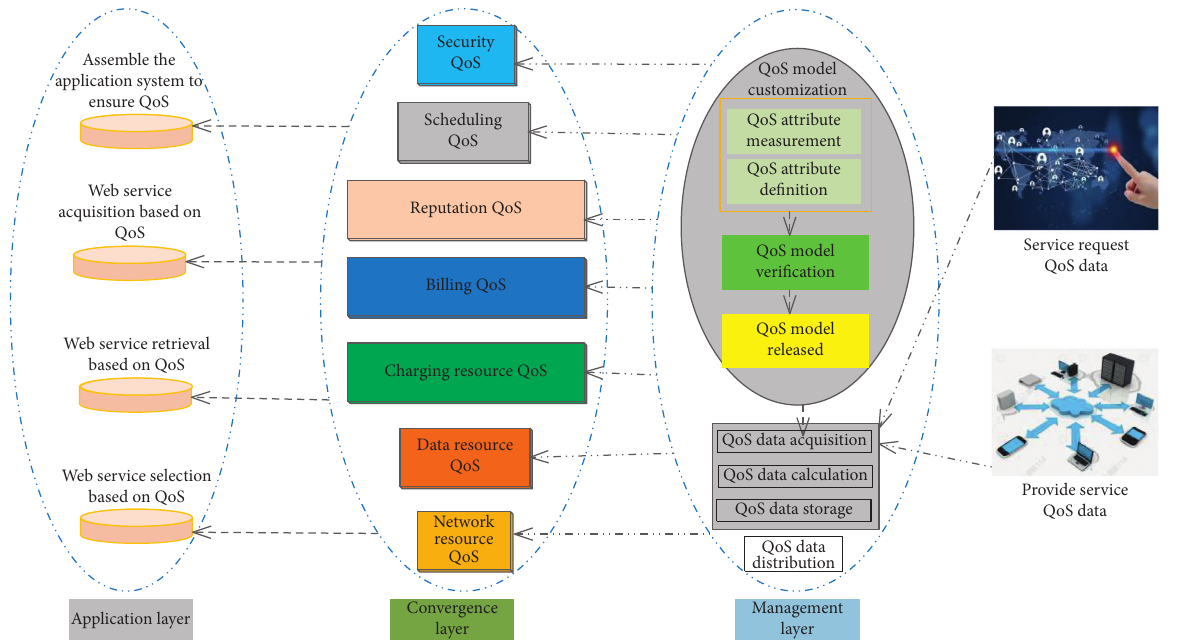
Figure 1: Web service QoS management